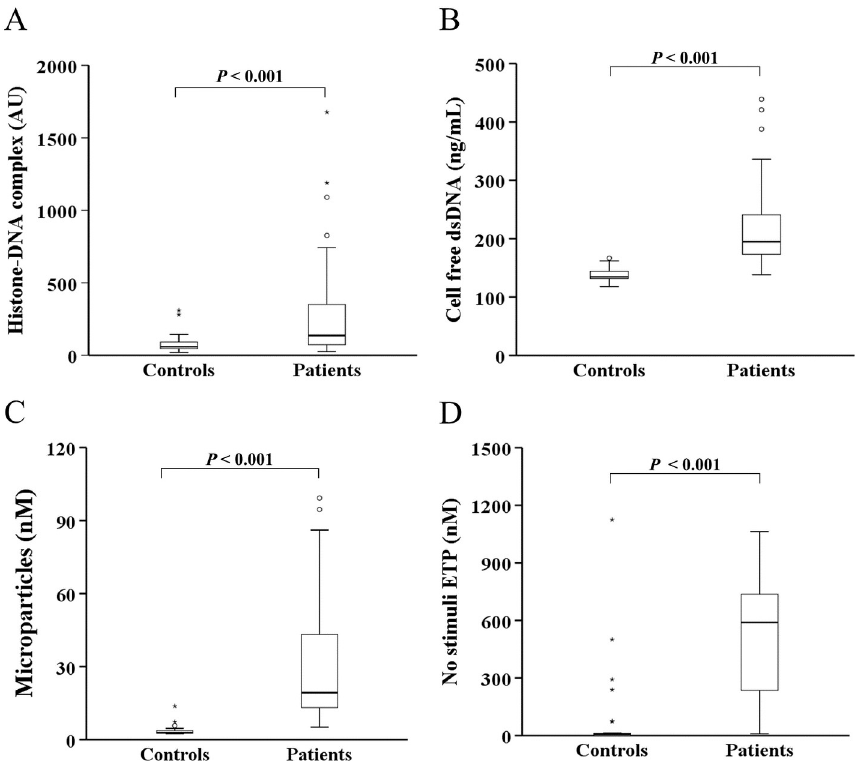
Fig 6. The circulating levels of NET and hypercoagulability markers are increased in patients with pancreatobiliary malignancy. The levels of (A) histone–DNA complex, (B) cell-free dsDNA, (C) microparticles, and (D) ETP in the absence of stimuli (no stimuli ETP) were measured in patients with pancreatobiliary malignancy (n = 62) and healthy controls (n = 30). Abbreviations: AU, arbitrary units.